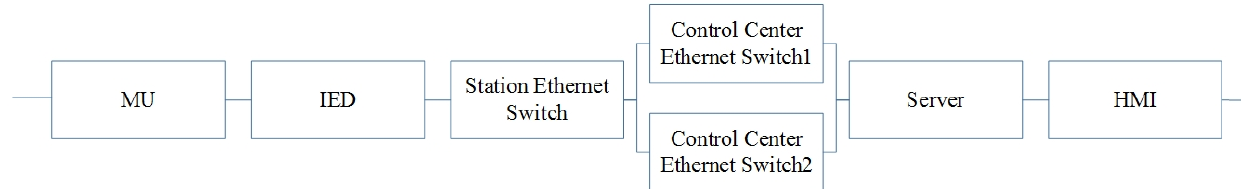
Figure 5. The RBD for the star-ring